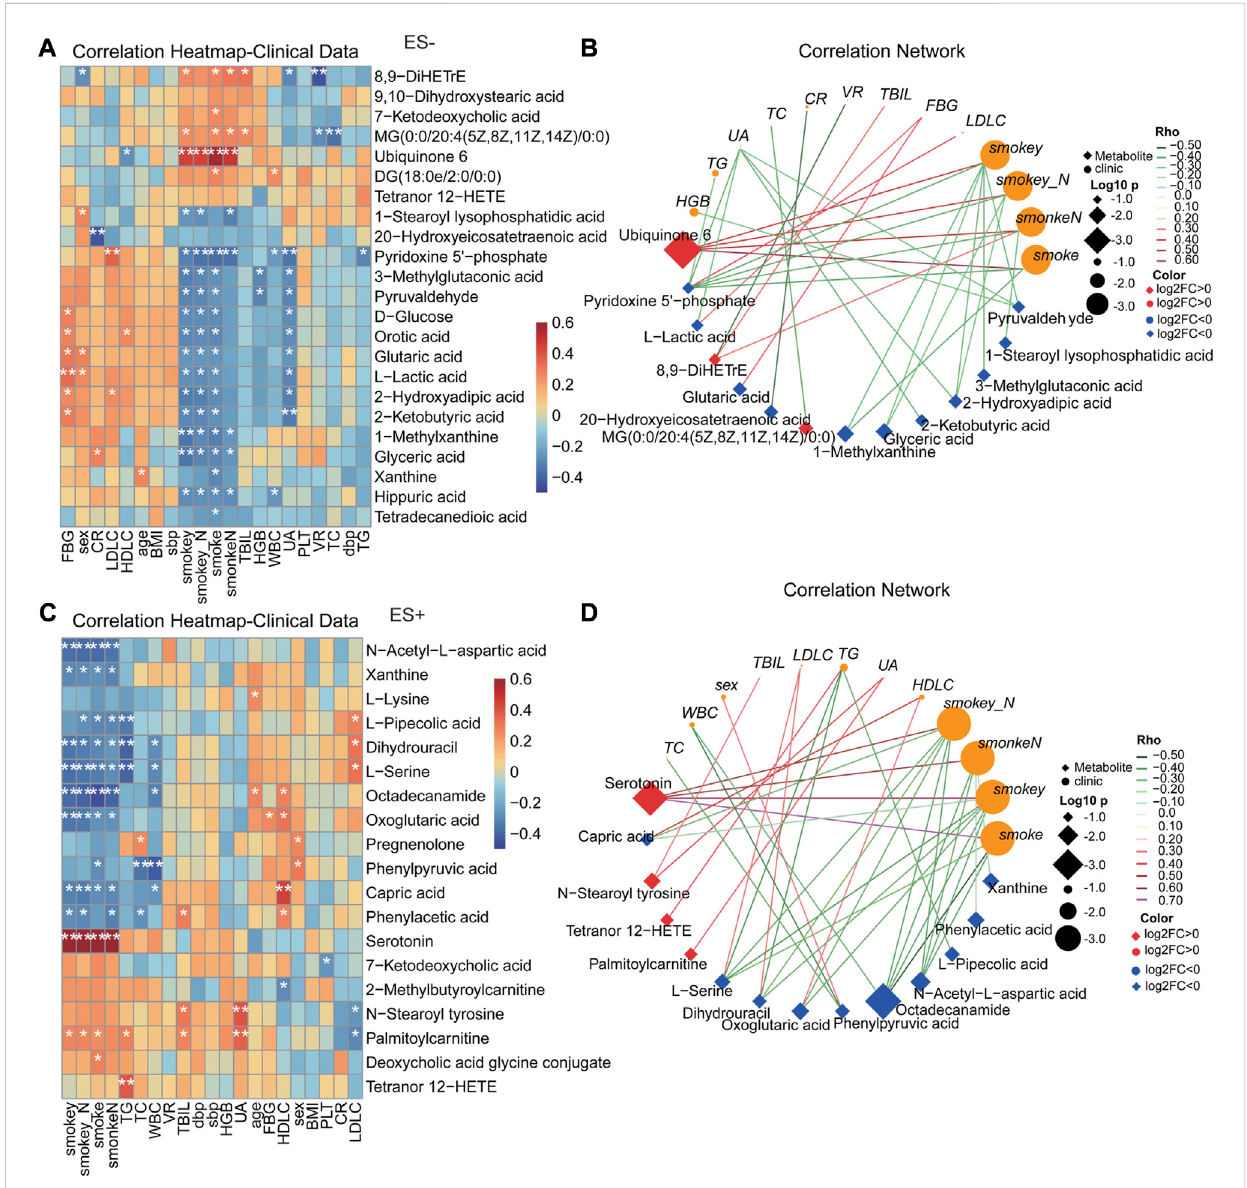
FIGURE 6 Correlation between clinical indexes of subjects and the important serum metabolites altered speci fi cally in smoking HTNs. (A, C) , Heat map of the Spearman ’ s rank correlation coef fi cient of differential serum metabolic compounds and clinical indexes. Red squares indicate positive associations between metabolites and clinical indexes; blue squares indicate negative associations. The statistical signi fi cance was labeled with * p < 0.05, ** p < 0.01, respectively. (B, D) , Correlation network describing the signi fi cant linkage between metabolites and clinical parameters. The correlation coef fi cient is ≥ 0.3 or ≤ − 0.3, and p < 0.05, tested by Spearman correlation. Color of the nodes has been updated to represent log2FC, and different data type for metabolite/clinical/microbes is denoted with the node shape. Log10 p -values is described with node size to highlight the major correlations,